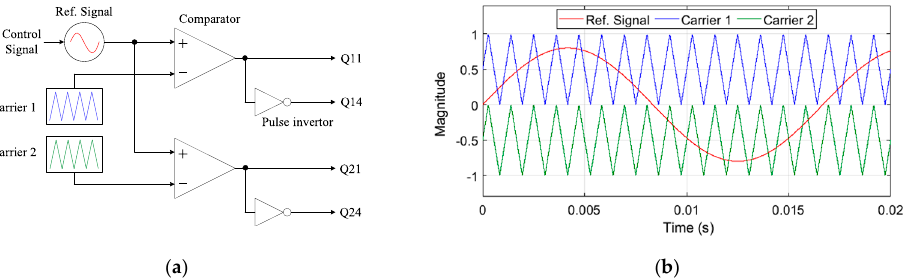
Figure 20. SPWM technique for an NPC converter (one leg is shown for illustration), ( a ) the tech- nique circuit, ( b ) plot of the input